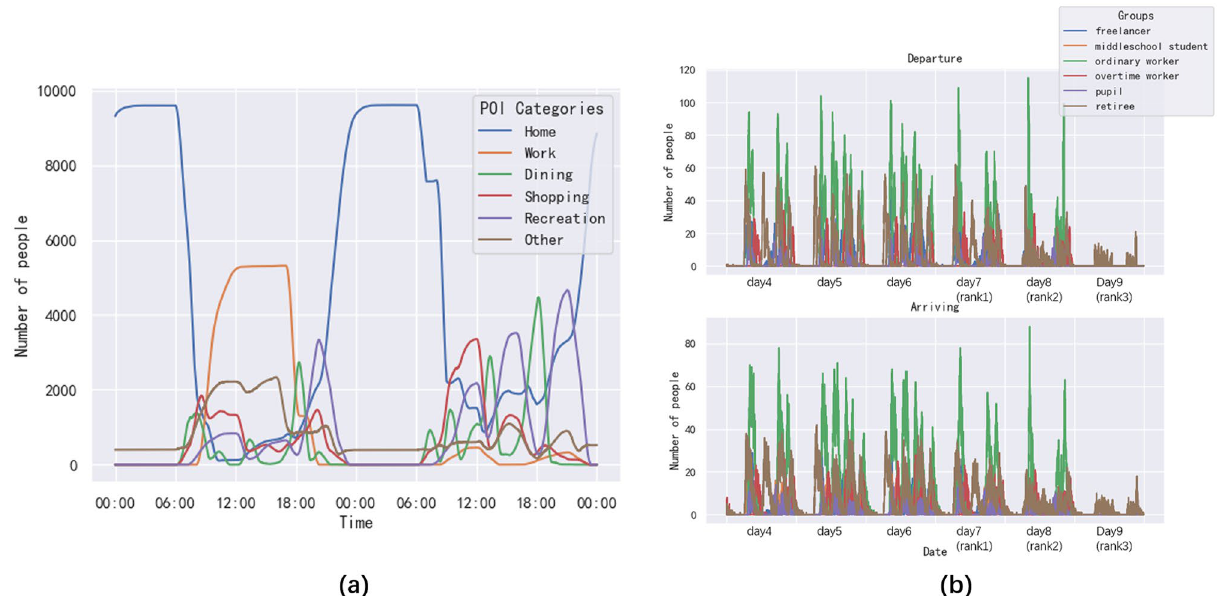
Figure 9. The number of people in different POI categories on day4 and day5 ( a ) and the impact of different restriction policies on the agent activities ( b ). ( a ) The main reason we chose day4 and day5 is that they are Friday and Saturday respectively, making it easy to compare. ( b ) We consider an agent leaving a place as a departure record and entering a place as an arriving record. We select day4 (working day), day5 and day6 (non- working days) as well as day7 (policy with rank1 implemented), day8 (policy with rank2 implemented), and day9 (policy with rank3 implemented) for the sake of up in geographic scope. We evaluated the consuming times for trajectory generation with maximum distances of 10 km, 100 km, and 1000 km to mimic the trips of city, provincial and country level. The average time consump- tions were 0.27 s, 0.35 s and 1.02 s, respectively (see Supplementary Table S4). Such results indicate that the time consumption did not increase linearly as the distance increases. Therefore, when the geographic scope is scaled